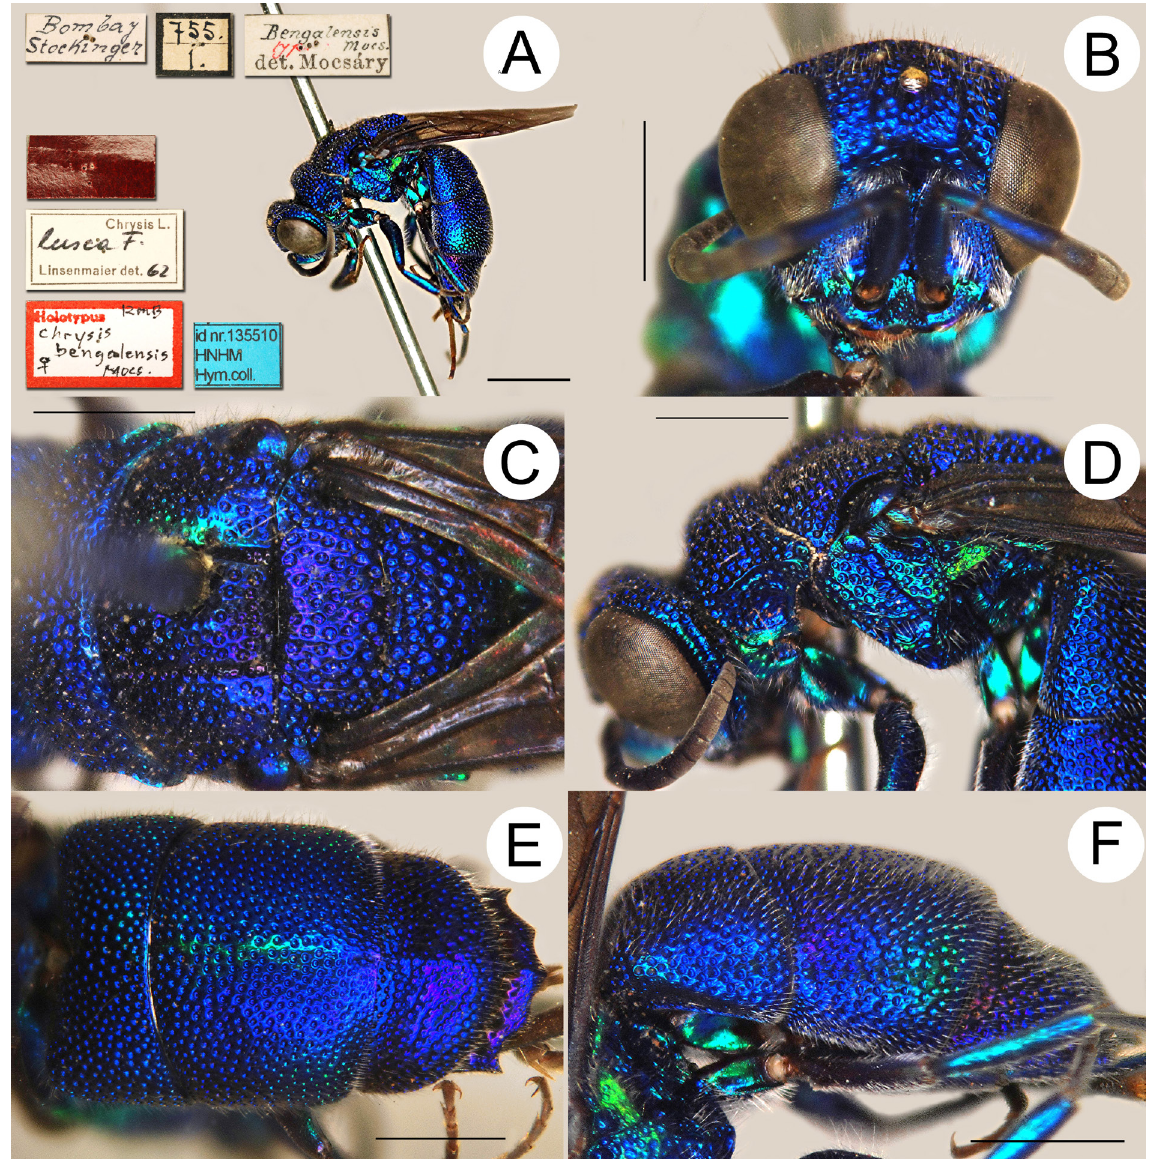
Fig. 1. Trichrysis bengalensis (Mocsáry, 1889), ♀, holotype (HNHM). A . Habitus, lateral view. B . Head, frontal view. C . Mesosoma, dorsal view. D . Head and mesosoma, lateral view. E . Metasoma, dorsal view. F . Metasoma, lateral view. Scale bars: 1.0